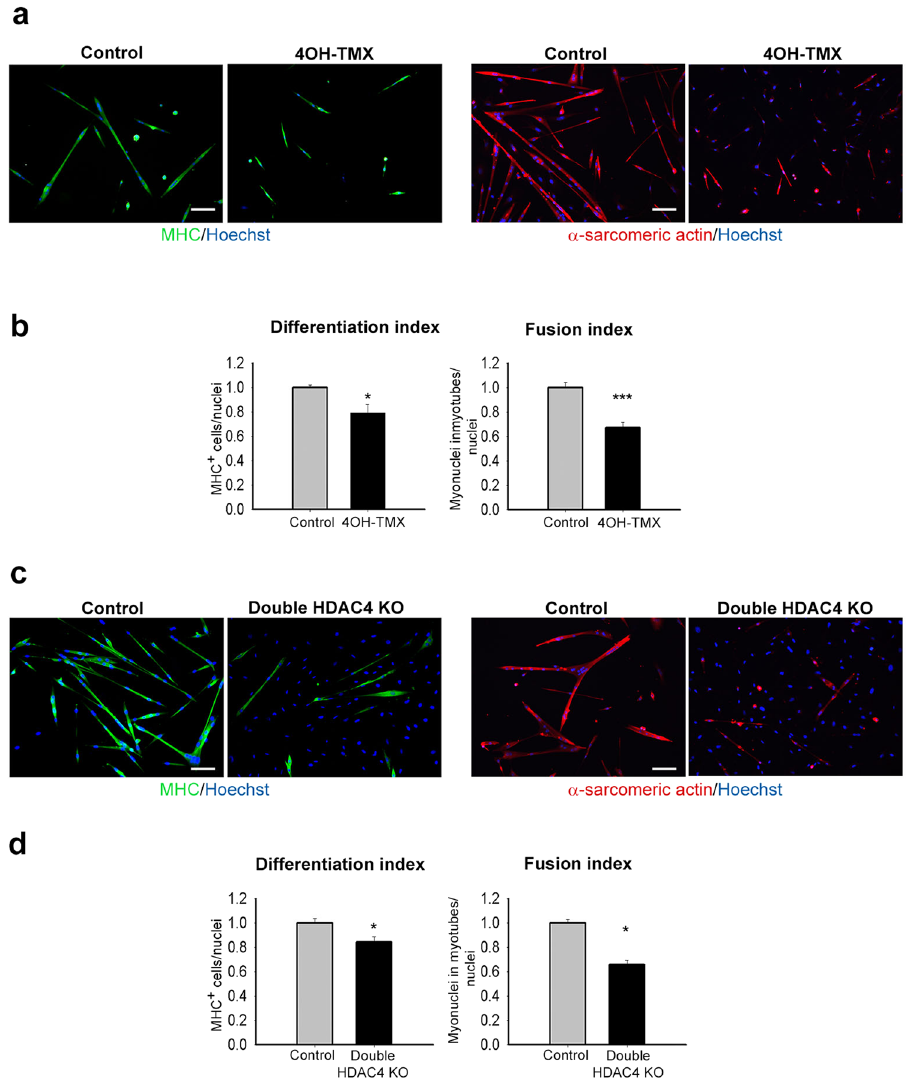
Figure 2. Deletion of HDAC4 in satellite cells is sufficient to inhibit differentiation. ( a ) Immunofluorescences for MHC and α -sarcomeric actin in satellite cells from HDAC4 fl/fl Pax7 CE mice treated with 4OH-TMX or vehicle, after three days in differentiation medium. Scale bar: 100 μ m. ( b ) Quantification of the differentiation and fusion indexes. n = 4 each sample. Data are presented as mean ± SEM. * p < 0.05; *** p < 0.001 (Student’s t-test). ( c ) Immunofluorescence for MHC and α -sarcomeric actin in HDAC4 KO plated at double density and control satellite cells, after three days in differentiation medium. Scale bar: 100 μ m. ( d ) Quantification of the differentiation and fusion indexes. n = 3 each sample. Data are presented as mean ± SEM. * p < 0.05 (Student’s